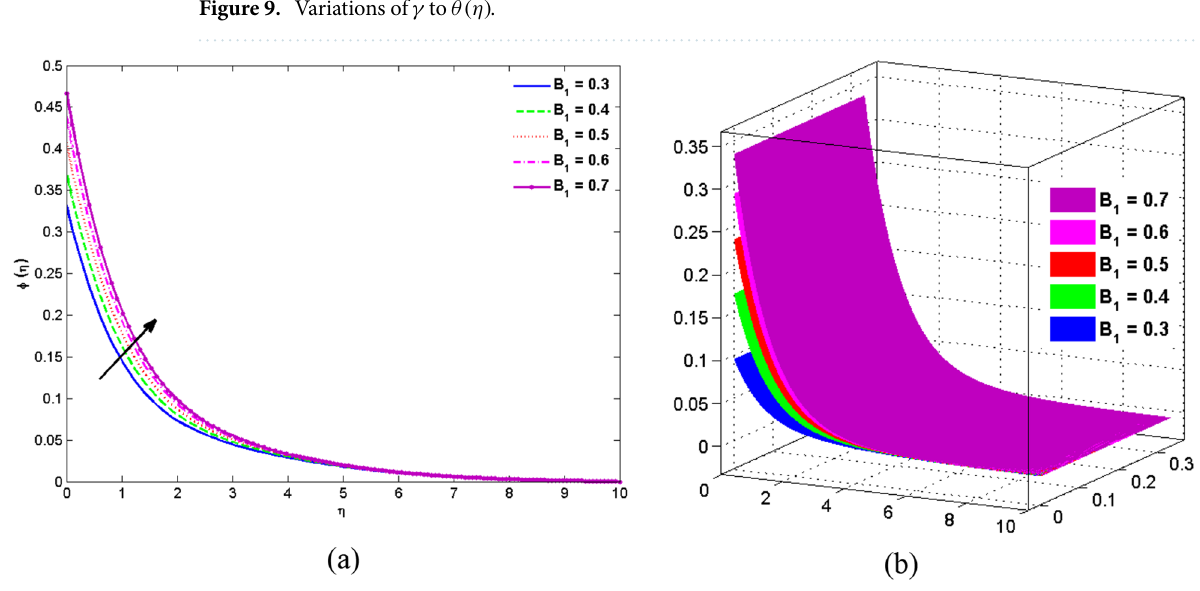
Figure 10. Variations of B 1 to φ(η)